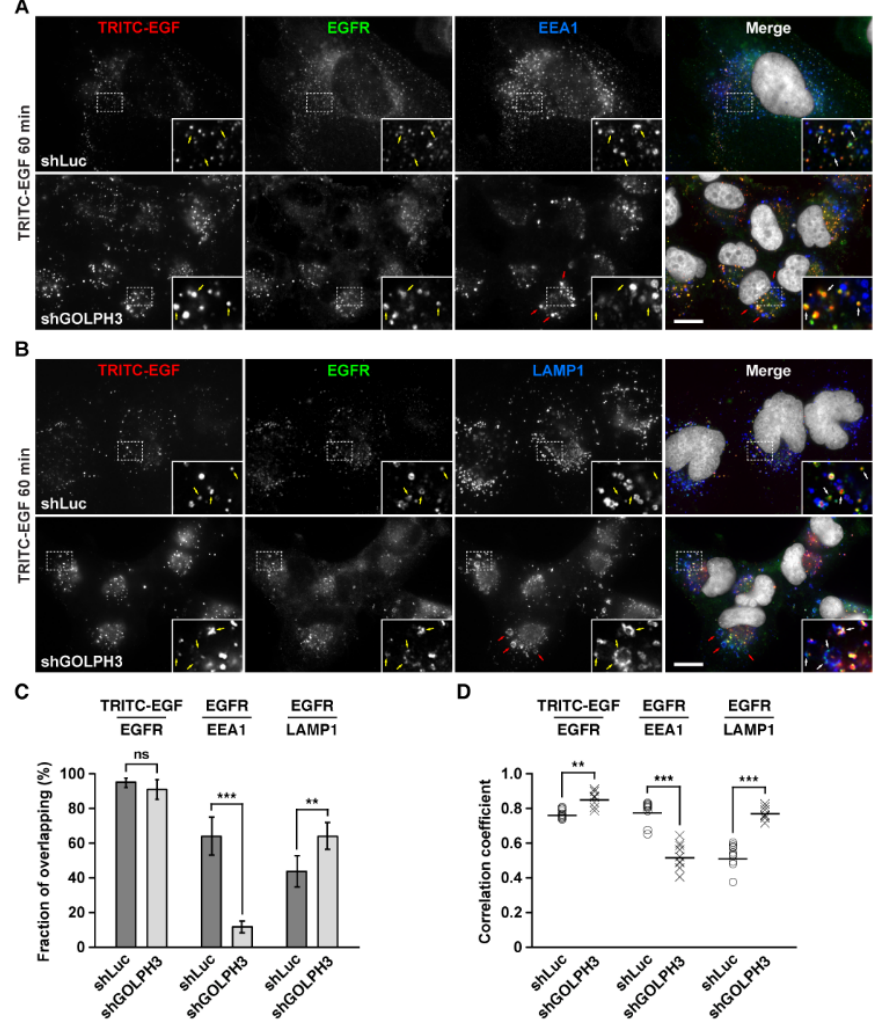
Figure 8. The knockdown of GOLPH3 in T98G cells promotes the accumulation of ligand-stimulated internalized EGFR in endo-lysosomal compartments. ( A , B ) The indicated cells grown in glass coverslips were incubated for 60 min with EGF conjugated to tetramethylrhodamine B isothiocyanate (TRITC-EGF; red channel). Cells were fixed, permeabilized, and double-labeled with sheep polyclonal antibody to EGFR and with either rabbit polyclonal antibody to EEA1 ( A ) or mouse monoclonal antibody to LAMP1 ( B ). Secondary antibodies were Alexa-488-conjugated donkey anti-sheep IgG (green channel) and either Alexa-647-conjugated donkey anti-rabbit IgG (blue channel; A) or Alexa-647-conjugated donkey anti-mouse IgG (blue channel; B) and nuclei were stained with DAPI (gray channel). Stained cells were examined by fluorescence microscopy. Merging red, green, blue, and grey channels generated the fourth image on each row; yellow indicates overlapping localization of the red and green channels, cyan indicates overlapping localization of the green and blue channels, magenta indicates overlapping localization of the red and blue channels, and white indicates overlapping localization of all three channels. Insets show 3× magnifications. Yellow and white arrows depict overlapping puncta; red arrows depict enlarged compartments. Bar, 10 µm. ( C ) Quantification of the fraction of fluorescent signal of TRITC-EGF overlapped to that of EGFR, of EGFR overlapped to that of EEA1, or of EGFR overlapped to that of LAMP1, from images of control (shLuc) and shGOLPH3 cells as those shown in A and B. Bars represent the mean ± standard deviation ( n = 10; ** p < 0.01; *** p < 0.001; ns, not statistically significant). ( D ) Scatter-plot graphs with Pearson’s correlation coe ffi cients obtained from co-localization analyses as described in C . ( n = 10; ** p < 0.01; *** p <